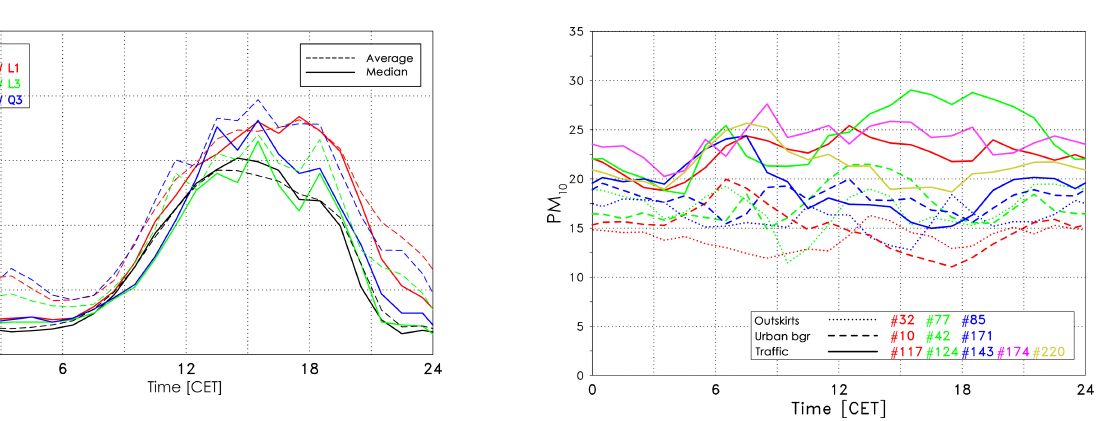
Figure 7. Diurnal cycle of hourly values of the MLH (in km) as determined from the different retrievals (see legend). Thick solid lines are for medians; thin broken lines for averages.